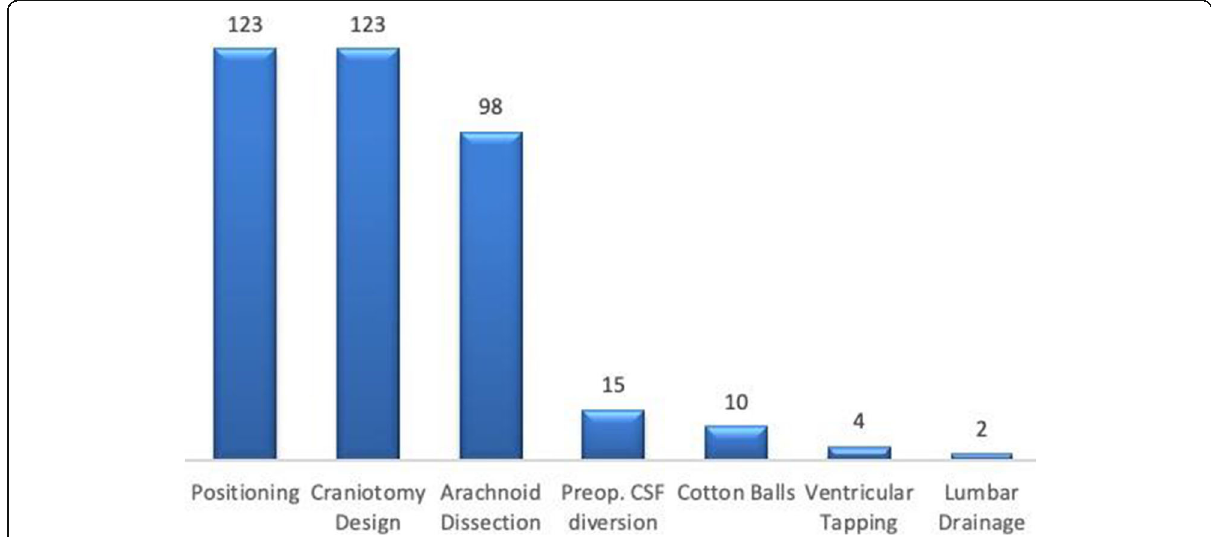
Fig. 5 Distribution of maneuvers used to eliminate fixed retraction in our patients. The number in each column refers to the number of patients where this maneuver was